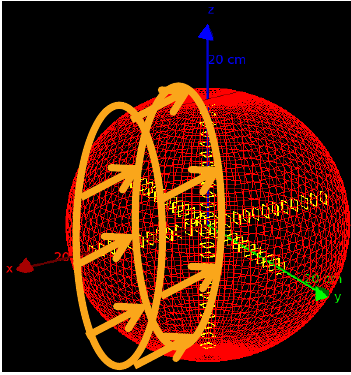
Fig. 1. Unique-multi-detectors Bonner sphere modelized with GEANT4, with a parallel beam in the direction : (-1 0 0). Here, a 25 cm diameter polyethylene sphere is represented in red, with one LiF detector placed each centimeter along x, y and z axis.